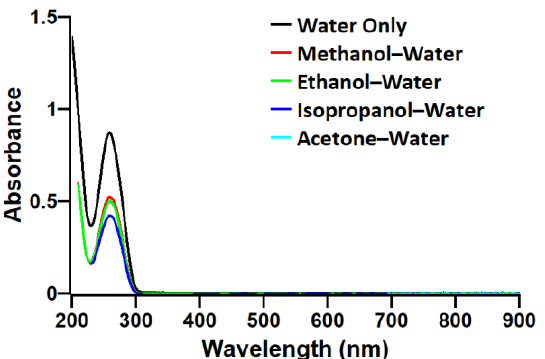
Figure 7. UV – VIS absorbance spectra of DNA solutions with/without solvents. Acetone – water DNA solution does not show the characteristic absorbance peak at 260 nm due to 330 nm UV cutoff of acetone. The optical path length of the cuvettes is 10 mm.